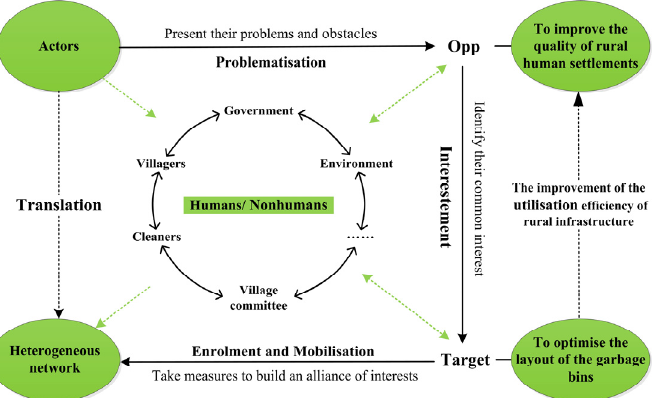
Figure 1. Research framework for garbage bin layout optimisation based on ANT.